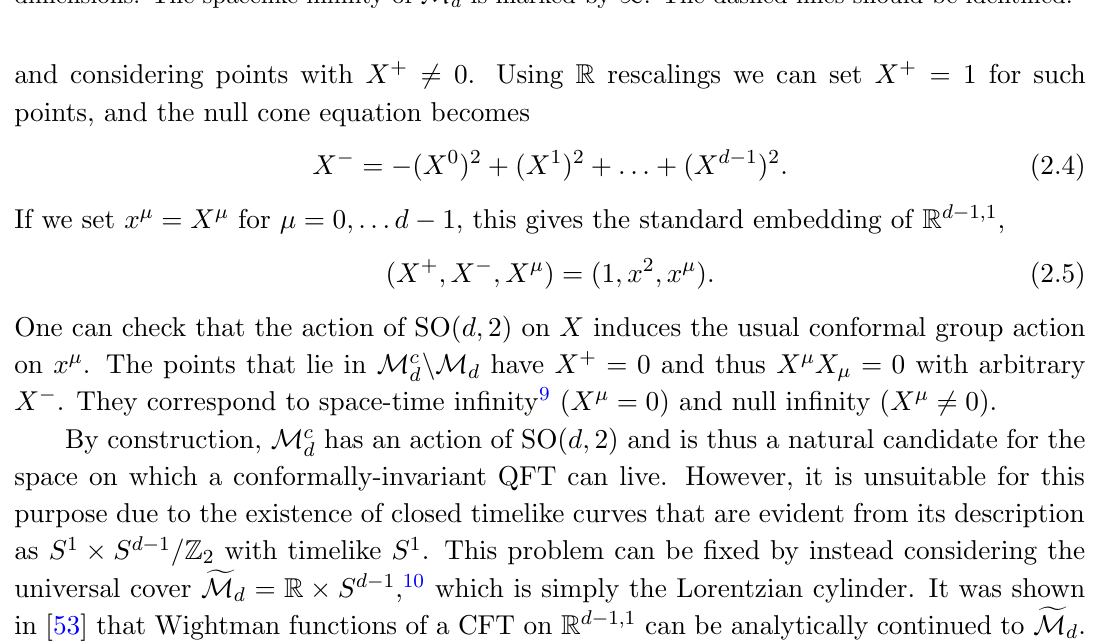
Figure 2. Poincare patch M d (blue, shaded) inside the Lorentzian cylinder f M d in the case of 2 dimensions. The spacelike in(cid:12)nity of M d is marked by 1 . The dashed lines should be